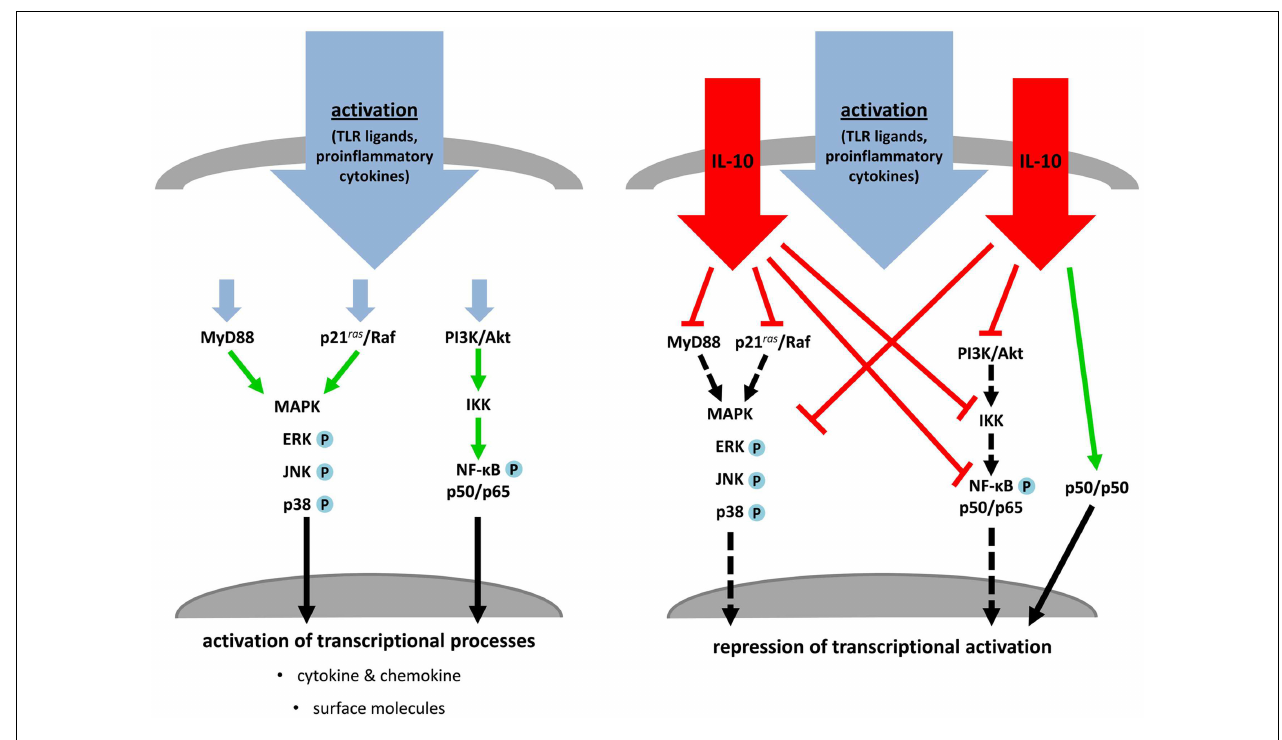
activated immune cells with IL-10 inhibits key molecules of the named pathways. MAPK- and MyD88-dependent signaling and NF- κ B activation are directly or indirectly prevented by IL-10.This leads to an abrogation of transcriptional and post-translational processes or induction of inhibitory transcriptional mechanisms